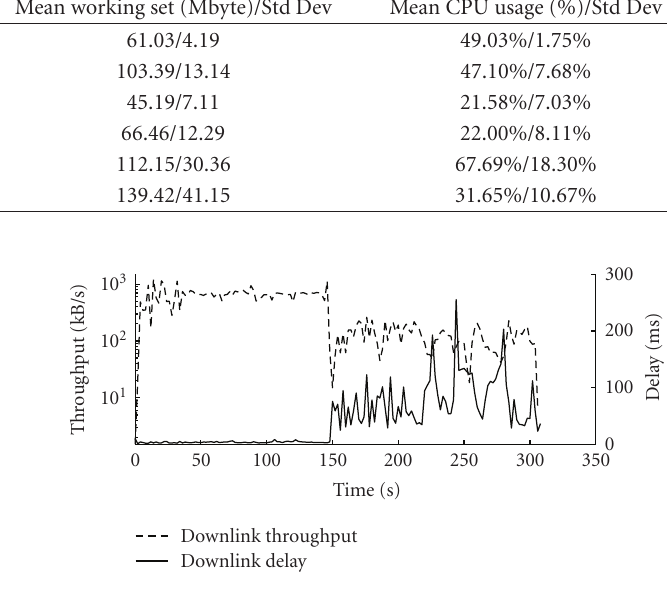
Figure 11: Downlink throughput and delay when both the game and the background tra ffi c share the same priority.